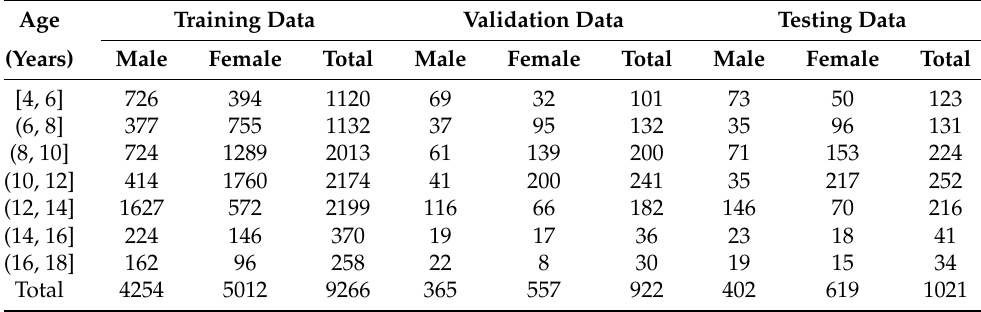
Table 2. Age distribution of training, validation, and testing datasets.